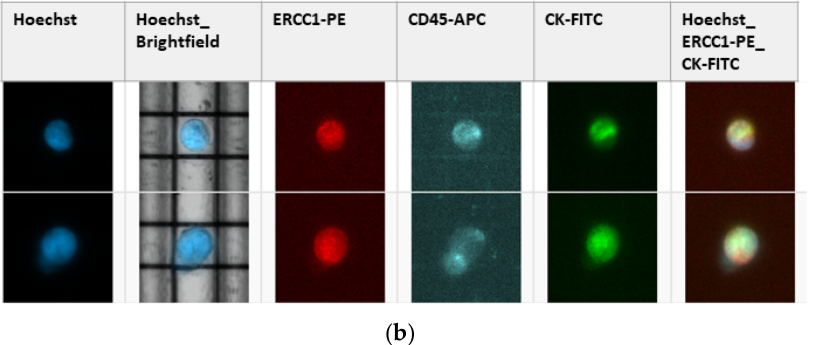
Figure A2. Final ERCC1- staining applied in two different healthy donor (hd) samples with spiked OVCAR-3 cells. Fluorescence panel generated with the DEPArray™ NxT. ( a ) Two OVCAR-3 cells Hoechst pos , ERCC1 pos , CD45 neg , CK pos in hd1. ( b ) Two OVCAR-3 cells Hoechst pos , ERCC1 pos , CD45 neg , CK pos in hd2.